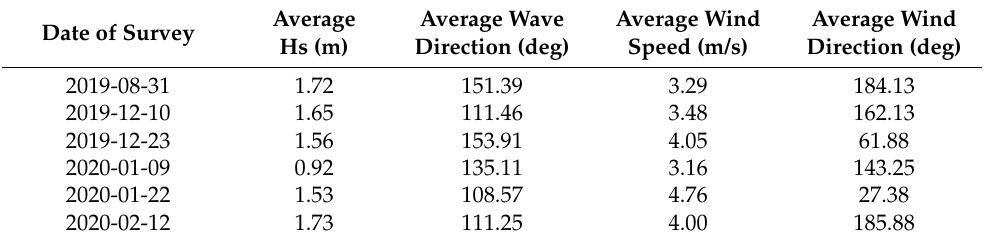
Table 1. Average wave and wind data recorded on the date of the profile from the 35.7031 ◦ S, 150.3439 ◦ E Waverider Buoy and the Moruya Airport weather station.